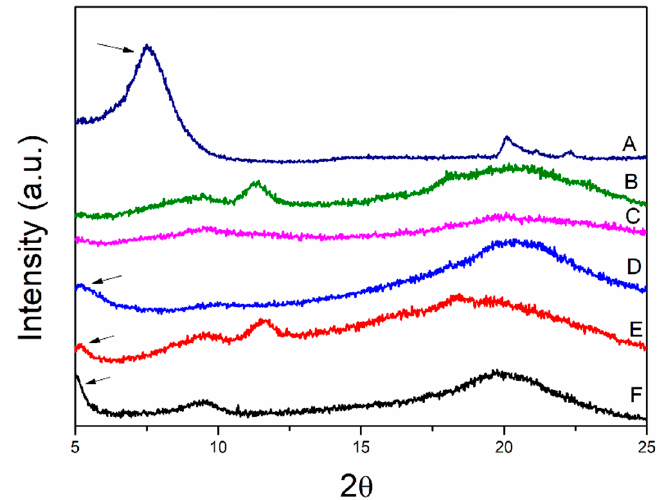
Figure 1. XRD of ( A ) pristine sodium montmorillonite (MMT), ( B ) chitosan film, ( C ) chitosan + MMT film, ( D ) chitosan + MMT + 2% GEO film, ( E ) chitosan + MMT + 1% GEO film, and ( F ) chitosan + MMT + 0.5% GEO film.